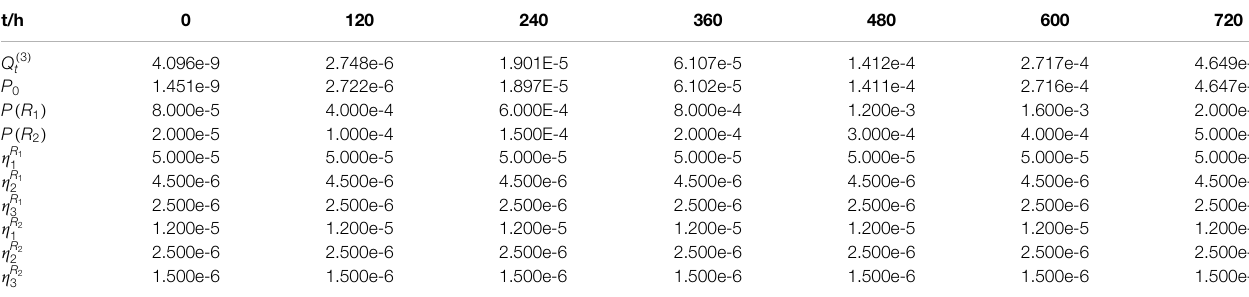
TABLE 1B | Parameters of CCCG (P 1 -FO,P 2 -FO,P 3 -FO).